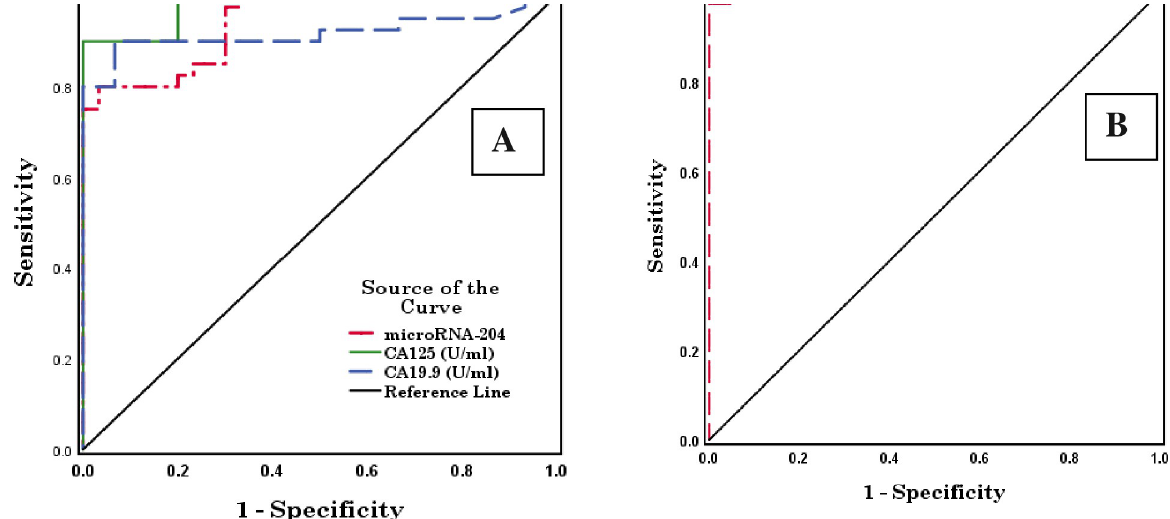
Fig 3. Receiver operating characteristic (ROC) curves of microRNA-204, CA125, and CA19.9 (A) and combined microRNA-204, CA125, and CA19.9 (B) in late ovarian cancer patients.